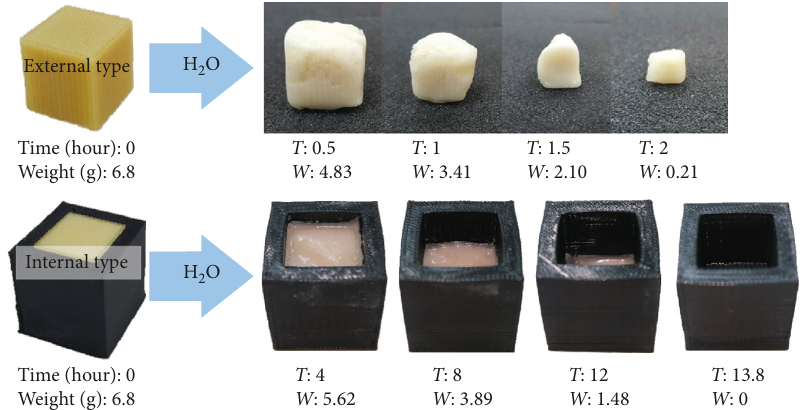
Figure 4: Experimental results of the dissolution of PVA supports in hydrogen